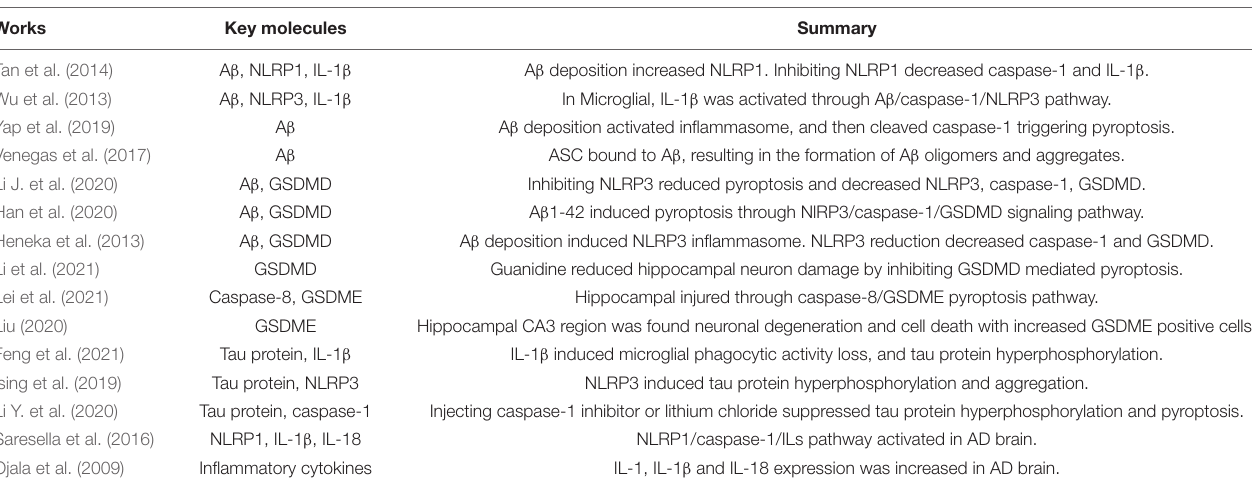
FIGURE 1 | Pyroptosis mechanism. Classical pathway is activated by caspase-1, it is activated by inflammasome, toxins, virus and bacterium through inflammasome; non-classical pathway is activated through caspase-4/5/11 by direct binding to LPS. After caspases’ cleavage on GSDMD or GSDME, the N-terminals translocate on cell membrane resulting in pore formation. Chemotherapy drug and TNF- α acts on caspase-3, and GSDME is activated directly by caspase-3 and GzmB or indirectly by caspase-8. TABLE 2 | Pyroptosis in